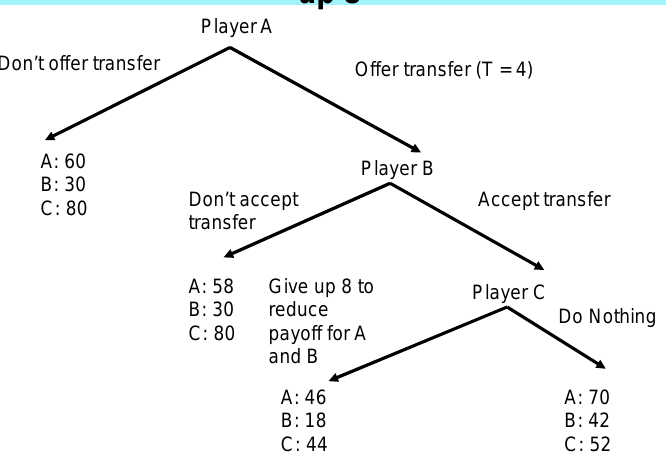
Games 2016 , 7 , 13 Figure B1. The structure of the experiment. Figure B1. The structure of the experiment. Figure 2: An Example where Player A offers 4